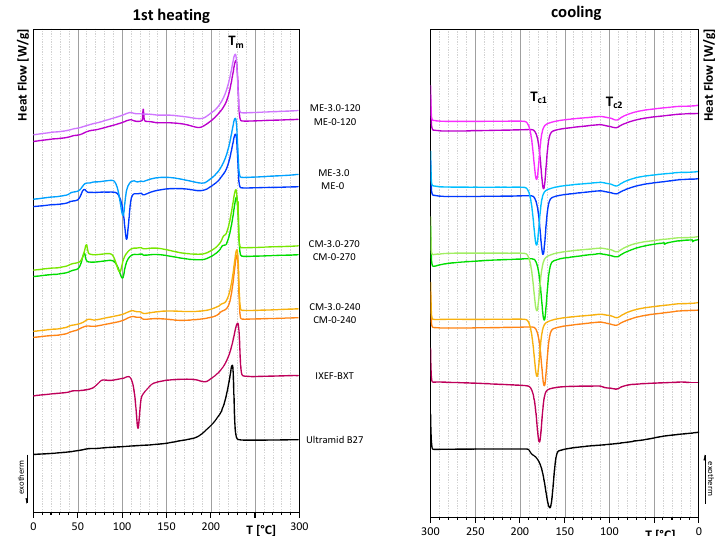
Figure 5. Differential scanning calorimetry (DSC) curves of the first heating cycle ( left ) and of cooling ( right ) of virgin polymers and films with 0 wt.-% and 3.0 wt.-% filler content.